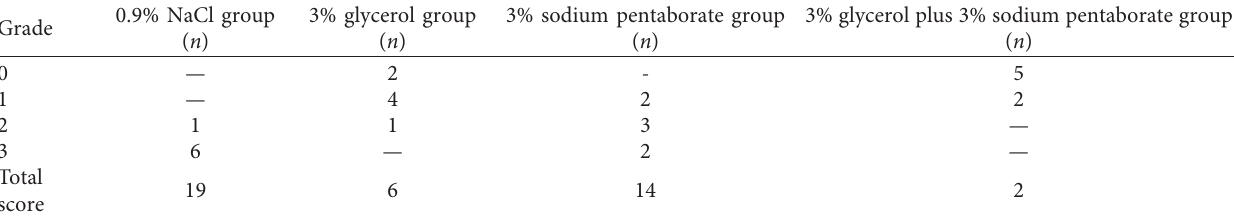
Table 3: Grades of macroscopic adhesion size.